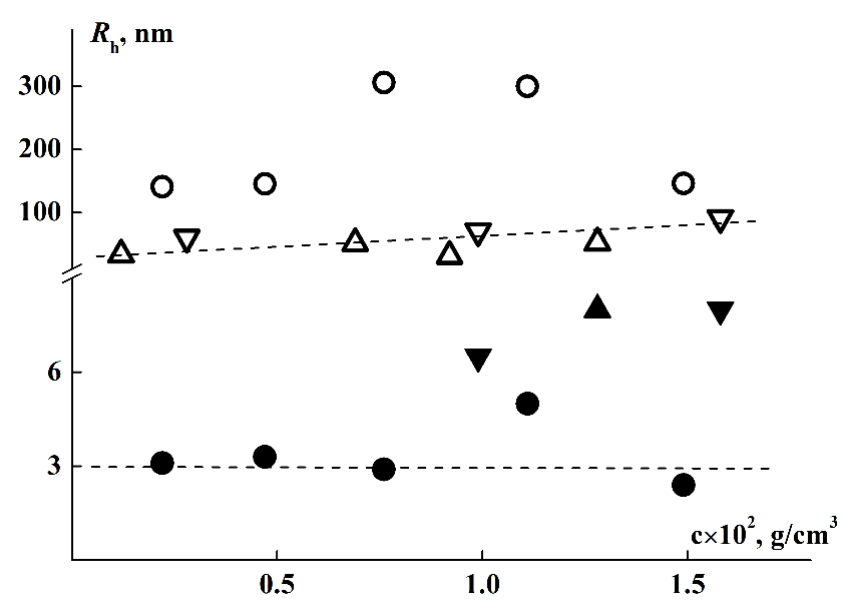
Figure 6. Concentration dependence of R f (solid) and R s (open) for copolymers 1 (circle), 2 (triangles), and 3 (inverse triangles) in water at T = 21 ◦